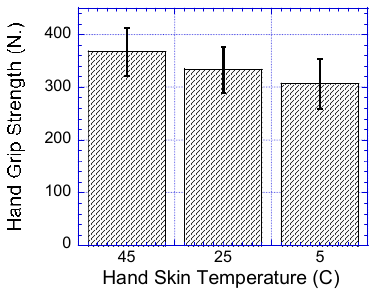
Figure 4. Effect of hand skin temperatures on HS.